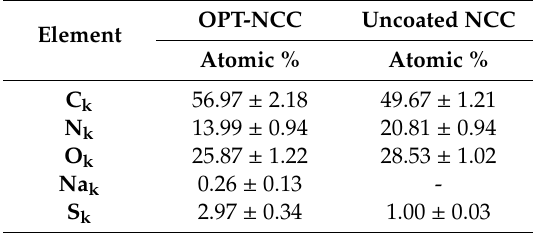
Table 9. Summary of elemental analysis for the physical mixture, NCC-OPT and co-crystal.